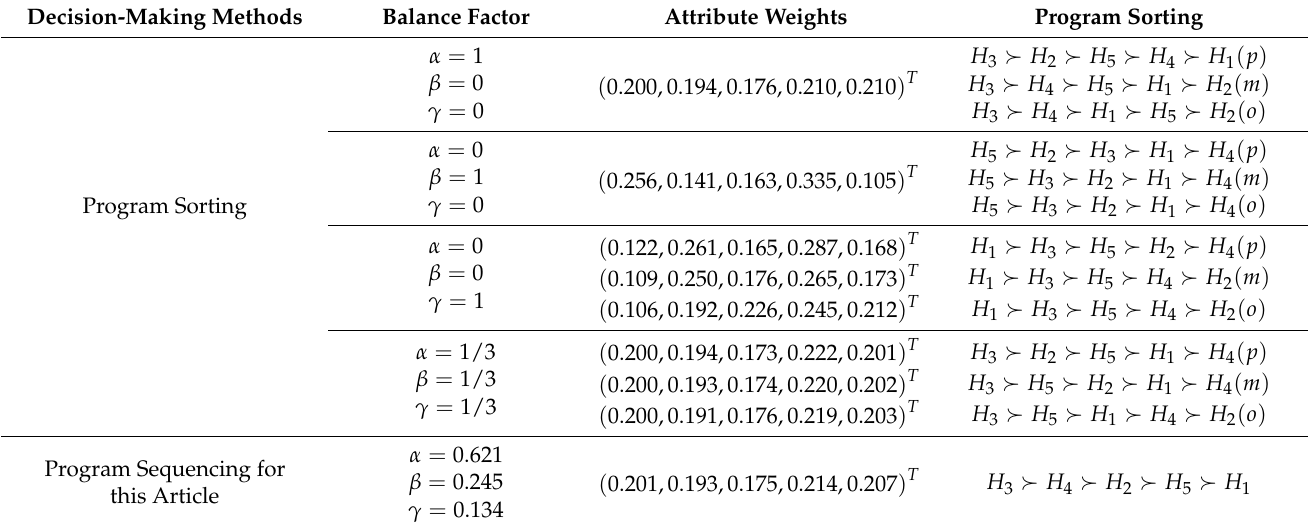
Table 4. Comparison with the method in the literature [29].